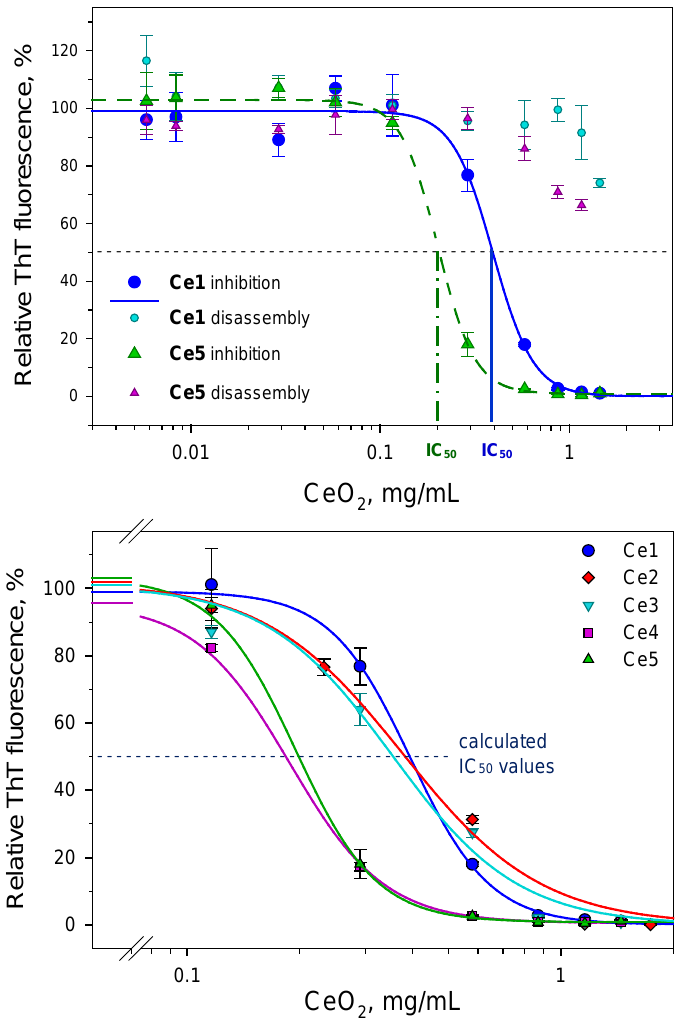
Figure 2. Concentration-dependent effects of CeO 2 NPs on self-association of insulin monitored via ThT fluorescence assay. Upper panel —Ce1- and Ce5-NP-induced inhibition of insulin fibrillization and disassembly of preformed insulin fibrils. Lower panel —Detailed view on differences in the half-maximal inhibitory (IC 50 ) values for all five studied CeO 2 NPs. The antiamyloidogenic effect was quantified as a function of CeO 2 NP concentrations ranging from 1:0.02 to 1:10 ratios ( w/w ) at a fixed 25 μM concentration of insulin/fibrils.